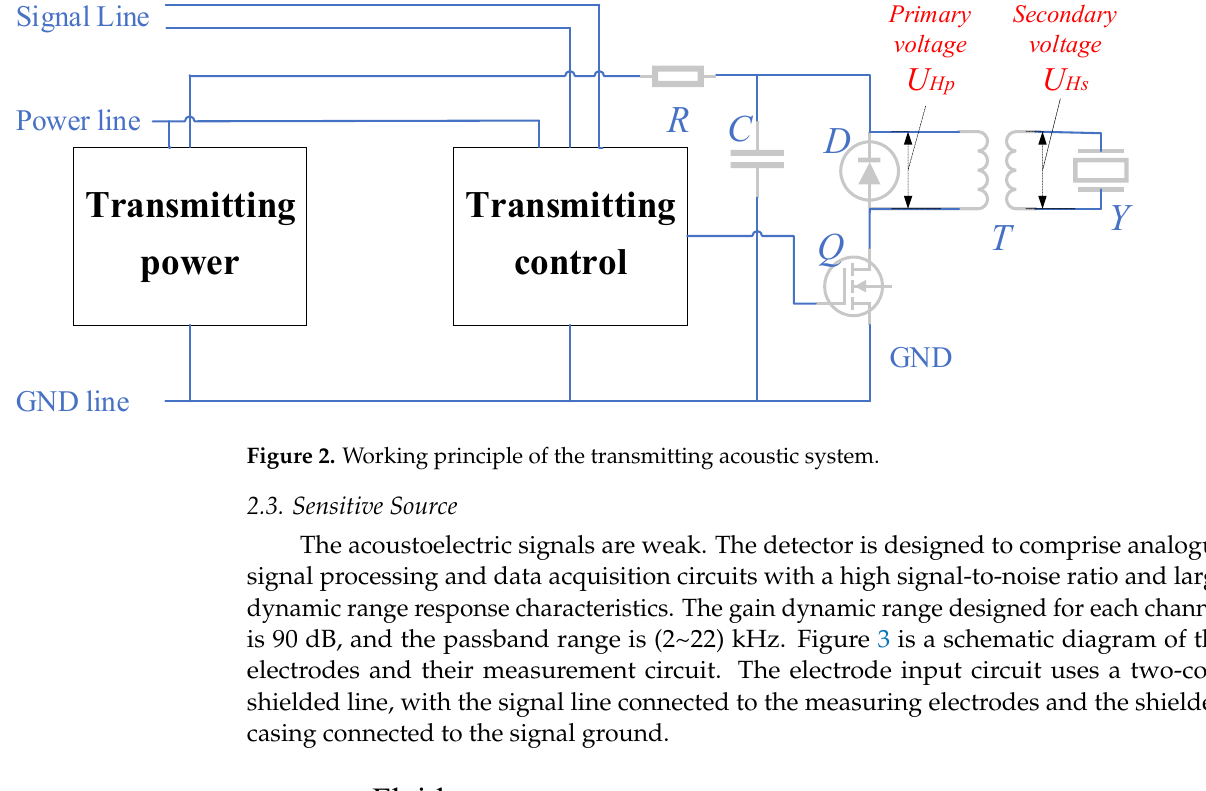
Figure 3. Schematic diagram of the electrodes and measurement circuits.